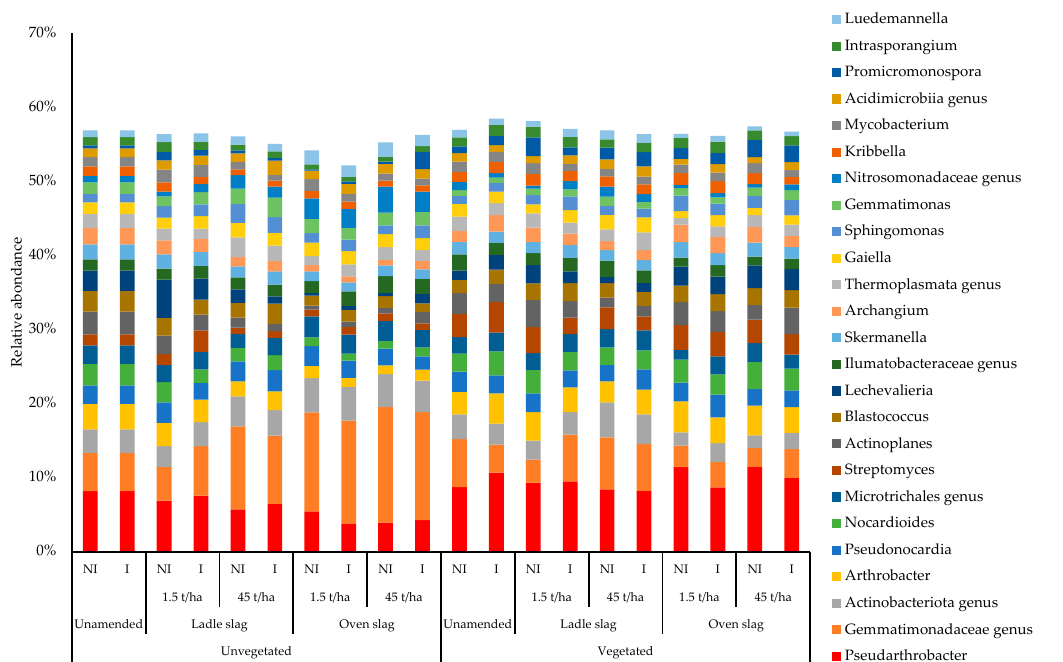
Figure 2. Abundances of the 25 most represented bacterial genus in soil. NI, non-inoculated; I, inoc- ulated.